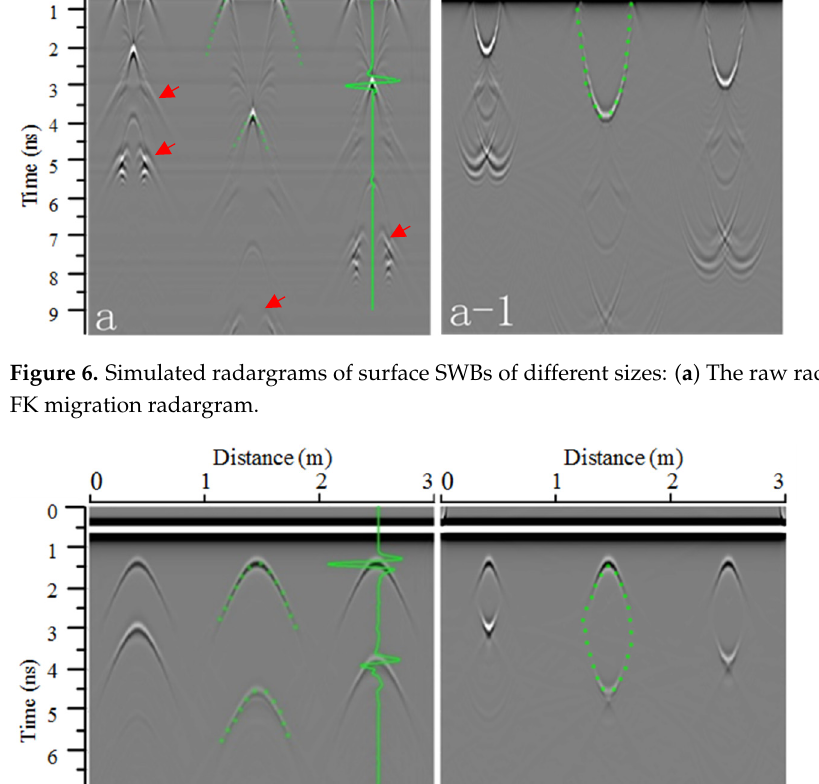
Figure 7. Simulated radargrams of subsurface SWBs of different sizes: ( a ) The raw radargram; ( a-1 ) the FK migration radargram.